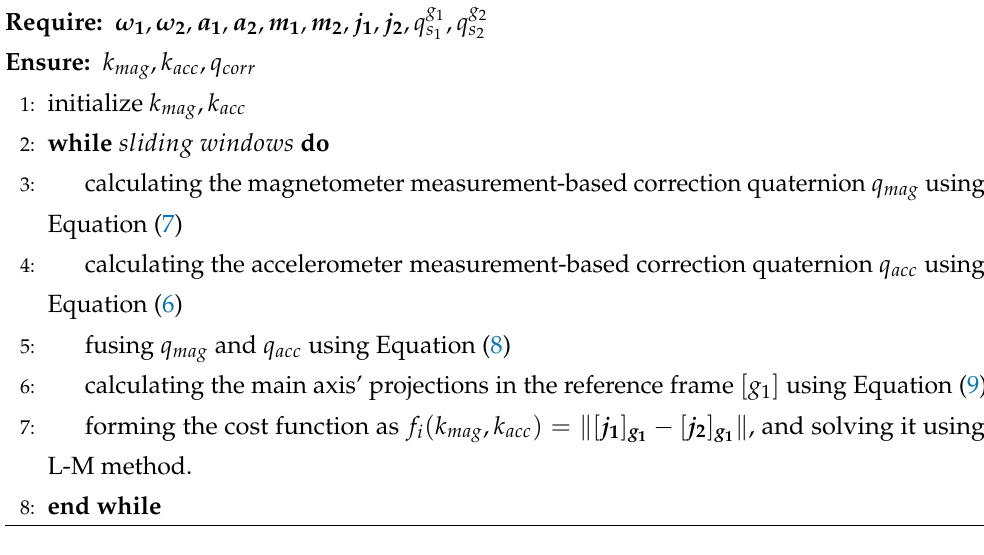
Algorithm 1 RFU method with comprehensive